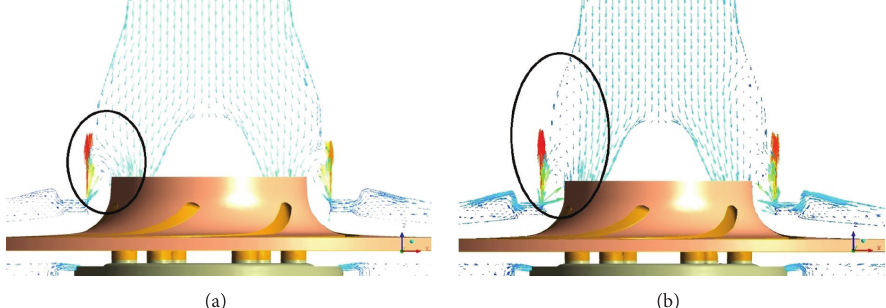
Figure 10: Influence of leakage flow on impeller suction regime. Right: water; left: viscous fluid.